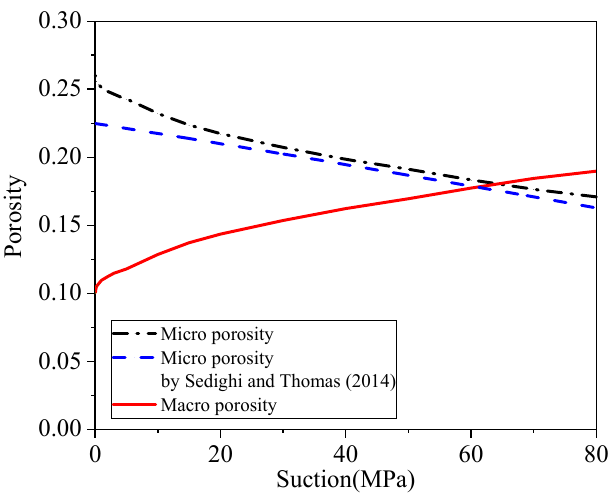
Figure 5. Macro and micro porosity against suction for compacted bentonite.